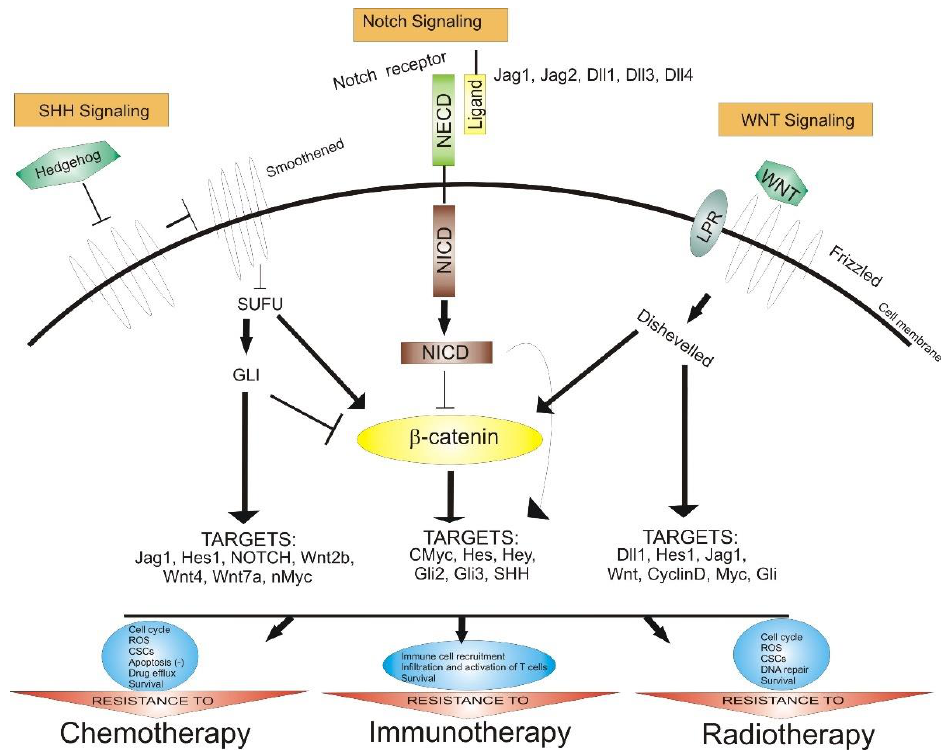
Figure 1. The role of Notch, SHH, and Wnt signaling pathways in anticancer therapy resistance. Abbreviations: SHH—Sonic hedgehog, SUFU—protein domain suppressor of fused protein, GLI—zinc finger protein, NECD—Notch extracellular domain, NICD—Notch intracellular domain, CSCs—cancer stem cells, ROS—reactive oxygen species, Jag—Notch ligand Jagged, Dll—delta-like ligand, Hes—hairy and enhancer of split, Myc—family of regulator genes and proto-oncogenes, point arrow—activation, block arrow—inhibition.